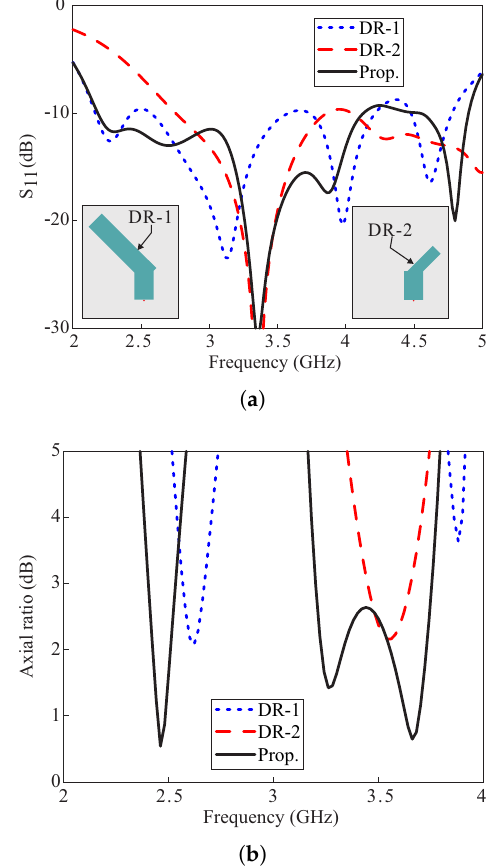
Figure 2. Comparison of the simulated results of the antenna designs with DR-1, DR-2, and proposed DRs as radiators: ( a ) Reflection coefficients; ( b ) Axial